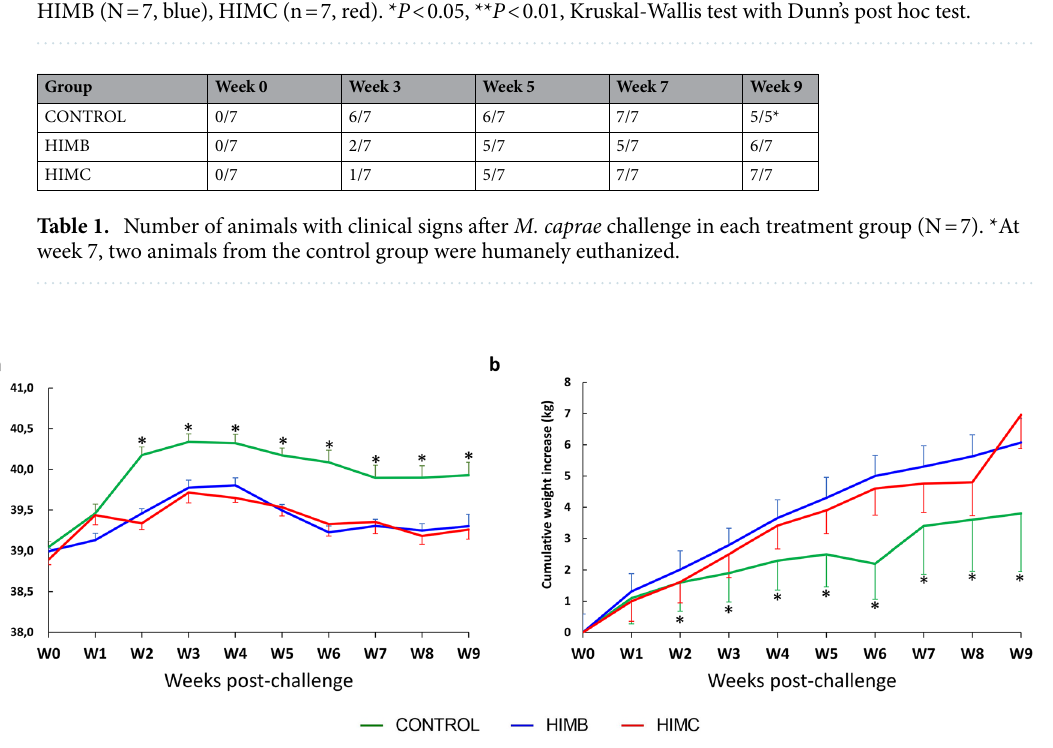
Figure 5. Rectal temperature and body weight. ( a ) Weekly mean rectal temperature of each group expressed in Celsius degrees (°C ± 95% CI). ( b ) Weekly mean cumulative body weight increases of each group expressed in ΔKg (Kg at each week post-challenge minus Kg at week 0) ± 95% CI. Groups: Unvaccinated control (green, N = 7 and N = 5 at weeks 8 and 9), vaccinated with HIMB (blue, N = 7) and vaccinated with HIMC (red, N = 7). * P < 0.05 between control and both vaccinated groups, one-way ANOVA with Tukey test for multiple pairwise